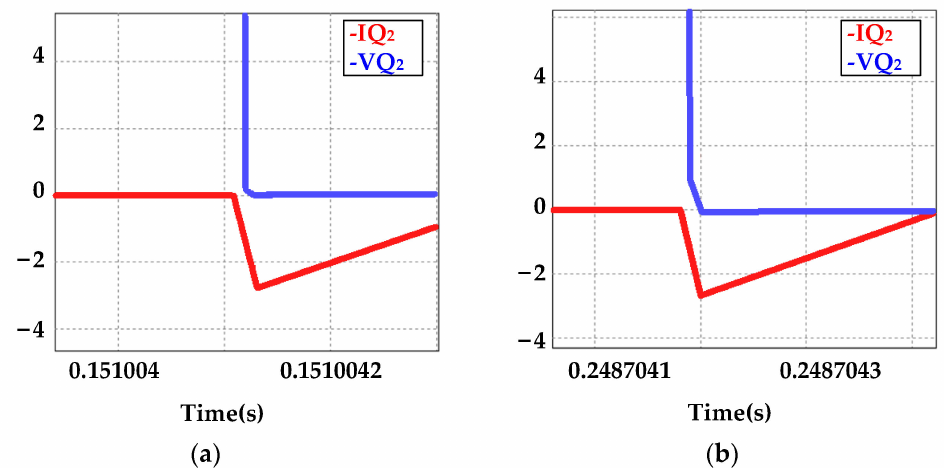
Figure 18. ( a , b ) are the waveform diagrams of the current and voltage of Q2 when the output voltage is stable, respectively.